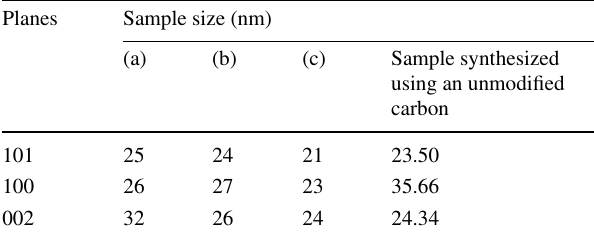
sample Samples Sample syn- (card No: 39-1451)